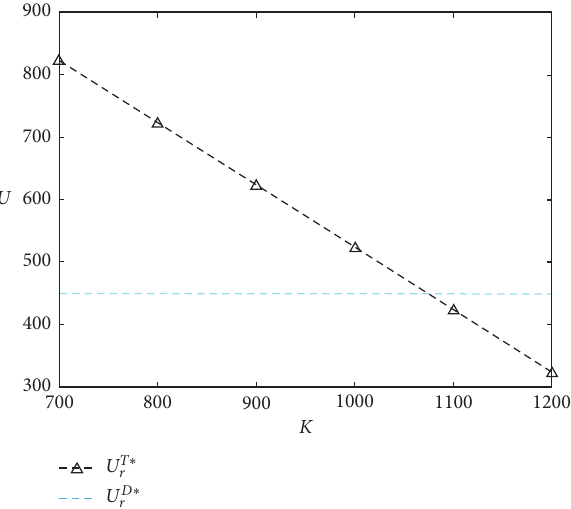
Figure 9: The effect of compensation on retailer